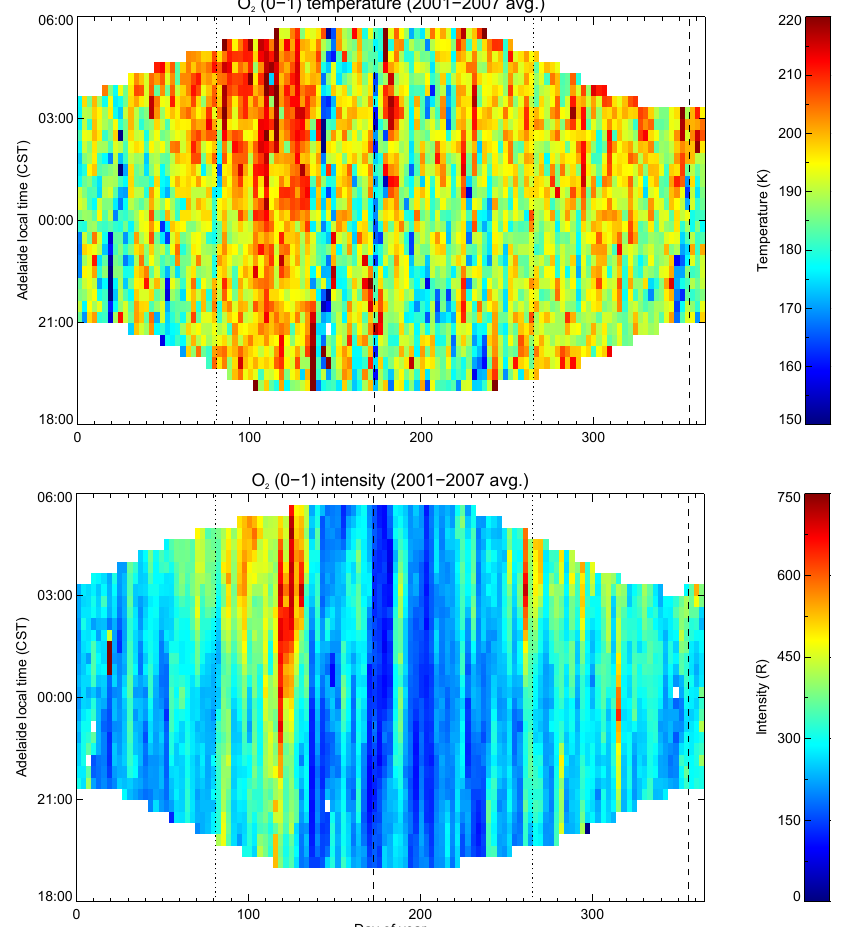
Figure 2. Top: the O 2 (0–1) temperature plotted as a function of time of day and time of year for a superposed year. The equinoxes are indicated by dotted lines, the solstices by dashed lines. There is a general increase in temperature at the time of the autumnal equinox, with the highest temperatures towards the end of the night at this time. There is a similar but less dramatic increase beginning around the time of the spring equinox. Bottom: as for top panel but for the O 2 (0–1) emission